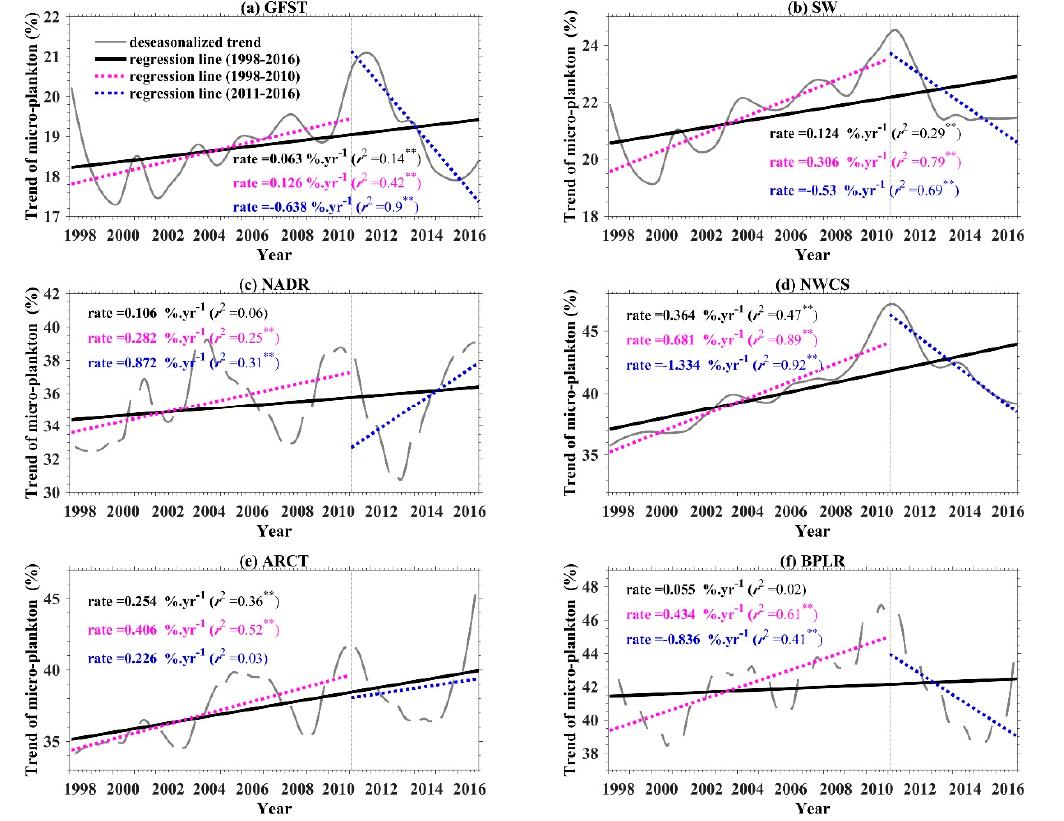
Figure 11. Linear regression of “smoothed deseasonalized trend” in the past 19 years (1998–2016, thick black line), 2000s (1998–2010, magenta line) and 2010s (2011–2016, blue line) in ecological provinces of ( a ) Gulf Stream, ( b ) Slope Waters, ( c ) North Atlantic Drift, ( d ) Northwest Continental Shelf, ( e ) Arctic Waters, and ( f ) Polar Boreal Current. Determination coefficient with “**” denotes p < 0.001.